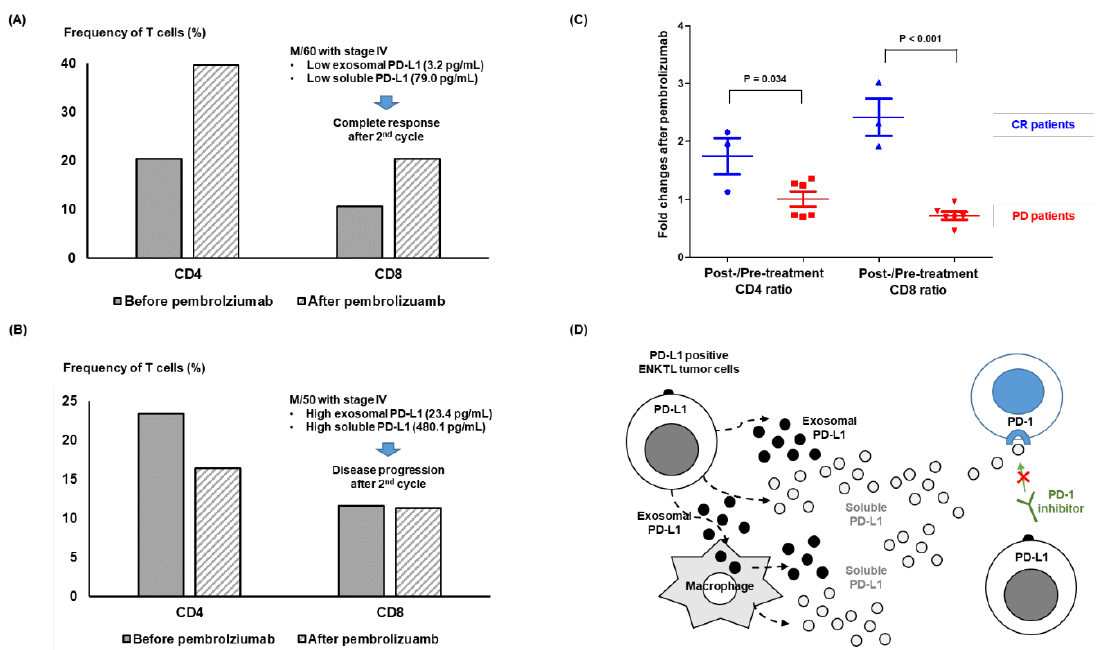
Figure 5. ( A ) A 60-year-old male with low exosomal and soluble PD-L1 achieved a complete response after the second cycle of pembrolizumab. The proportion of CD4 and CD8 cells was compared before and after pembrolizumab in this patient. The flow cytometry showed an increase in CD4 and CD8 T-cells after pembrolizumab treatment. ( B ) A 50-year-old male with high exosomal and soluble PD-L1 showed disease progression after the second cycle of pembrolizumab. The proportion of CD4 cells after pembrolizumab treatment was lower than that of pre-treatment CD4 cells, and the increase of CD8 cells did not occur in this patient, who failed to respond to pembrolizumab. ( C ) Fold changes after pembrolizumab treatment were compared between CR and PD patients. The post-/pre-treatment CD4 and CD8 ratio was significantly higher in CR patients than in PD patients, implying the correlation of response to pembrolizumab with T-cell activation after pembrolizumab treatment. CR: complete response; PD: progressive disease. ( D ) A proposed model of soluble and exosomal PD-L1 influencing the efficacy of PD1 inhibitors in patients with